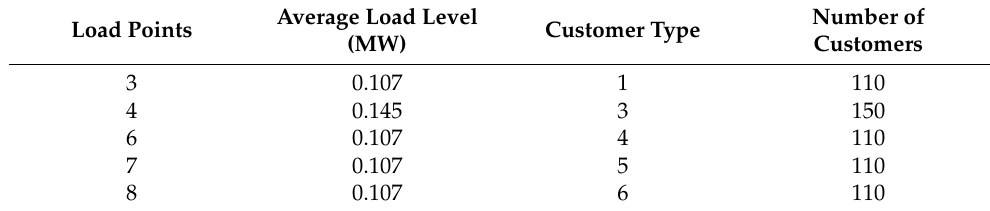
Table A2. A 32-node heat network load and customer data